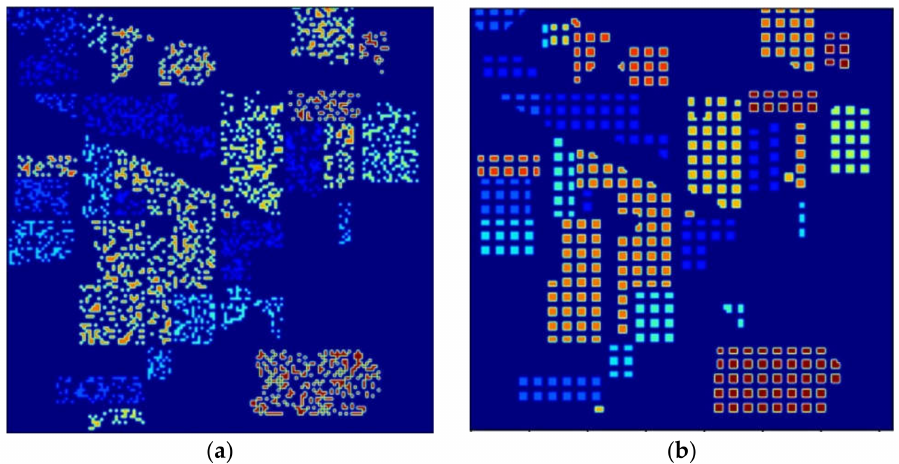
Figure 12. Examples of the sample distribution for the training set for the Indian Pines dataset, for the same number of samples per class as illustrated for the window size w = 3 for: ( a ) random selection, ( b ) sampling-controlled